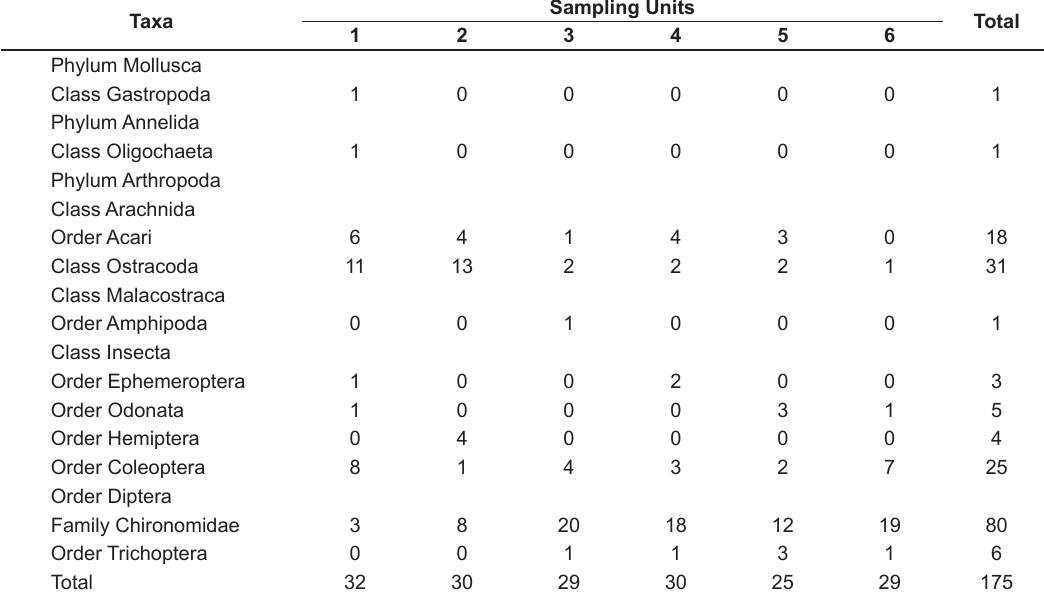
Table 2. Macroinvertebrates abundance collected in six sampling units during rainy season (May, 2013) at protected area - Biological Reserve of Saltinho, Tamandare city – Pernambuco,